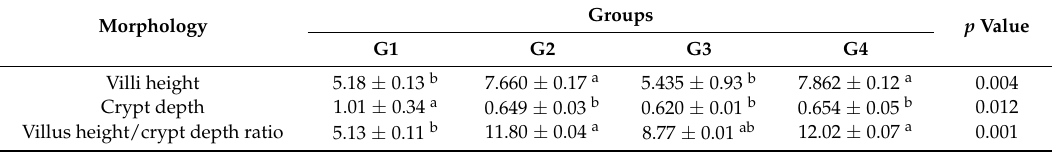
Table 3. Effect of dietary supplementation of C. butyricum and S. cerevisiae on the villi length ( µ M) and crypt depth ( µ M) in broiler